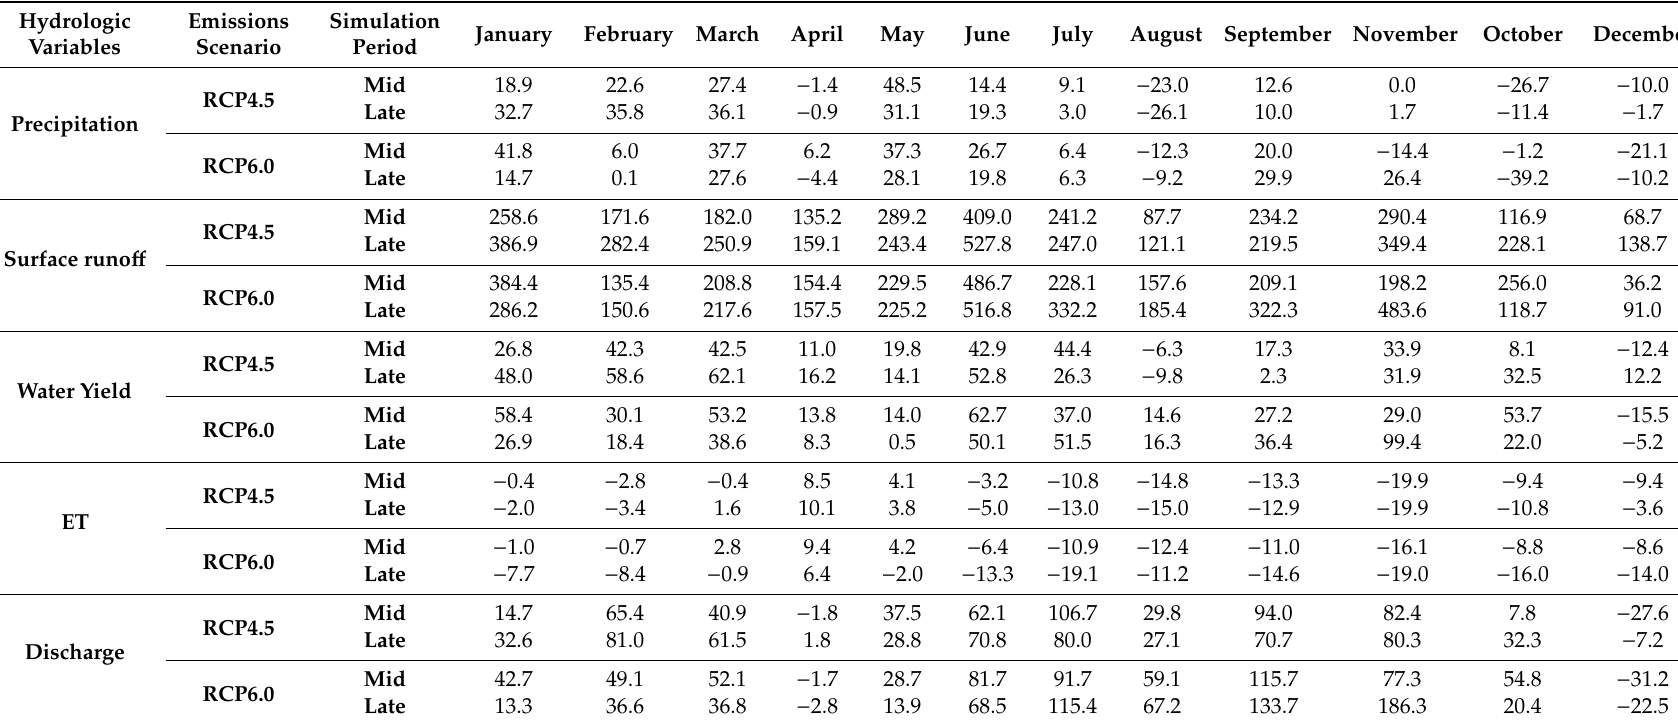
Table 9. Basin-wide monthly average of hydrologic variables in UCS based on the three models under moderate and severe scenarios. Hydrologic Variables Precipitation